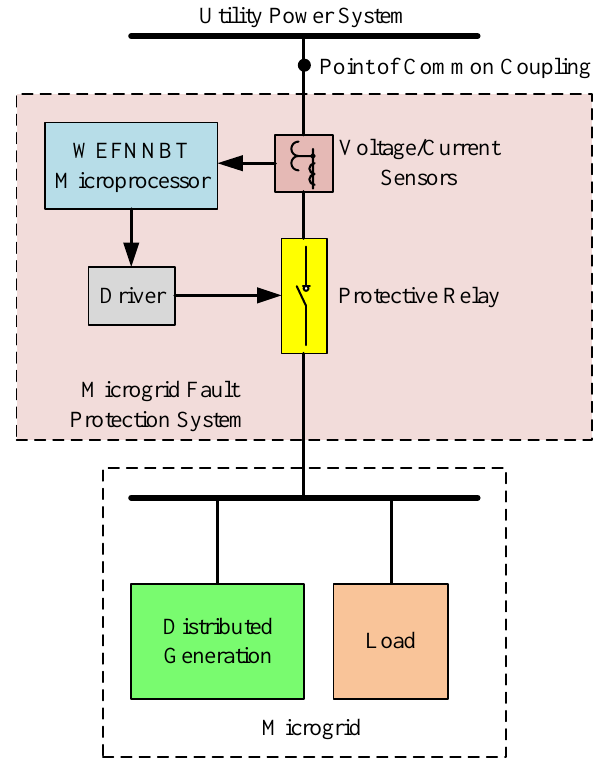
Figure 1. Architecture of microgrid fault protection system.